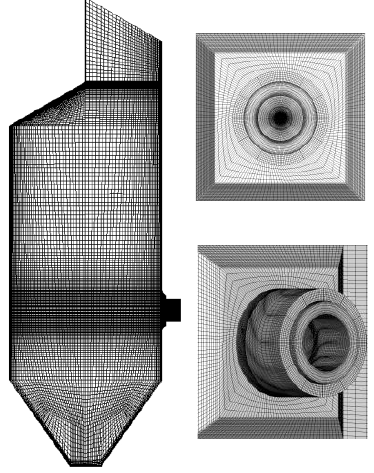
Figure 4. Meshing of computational domain.